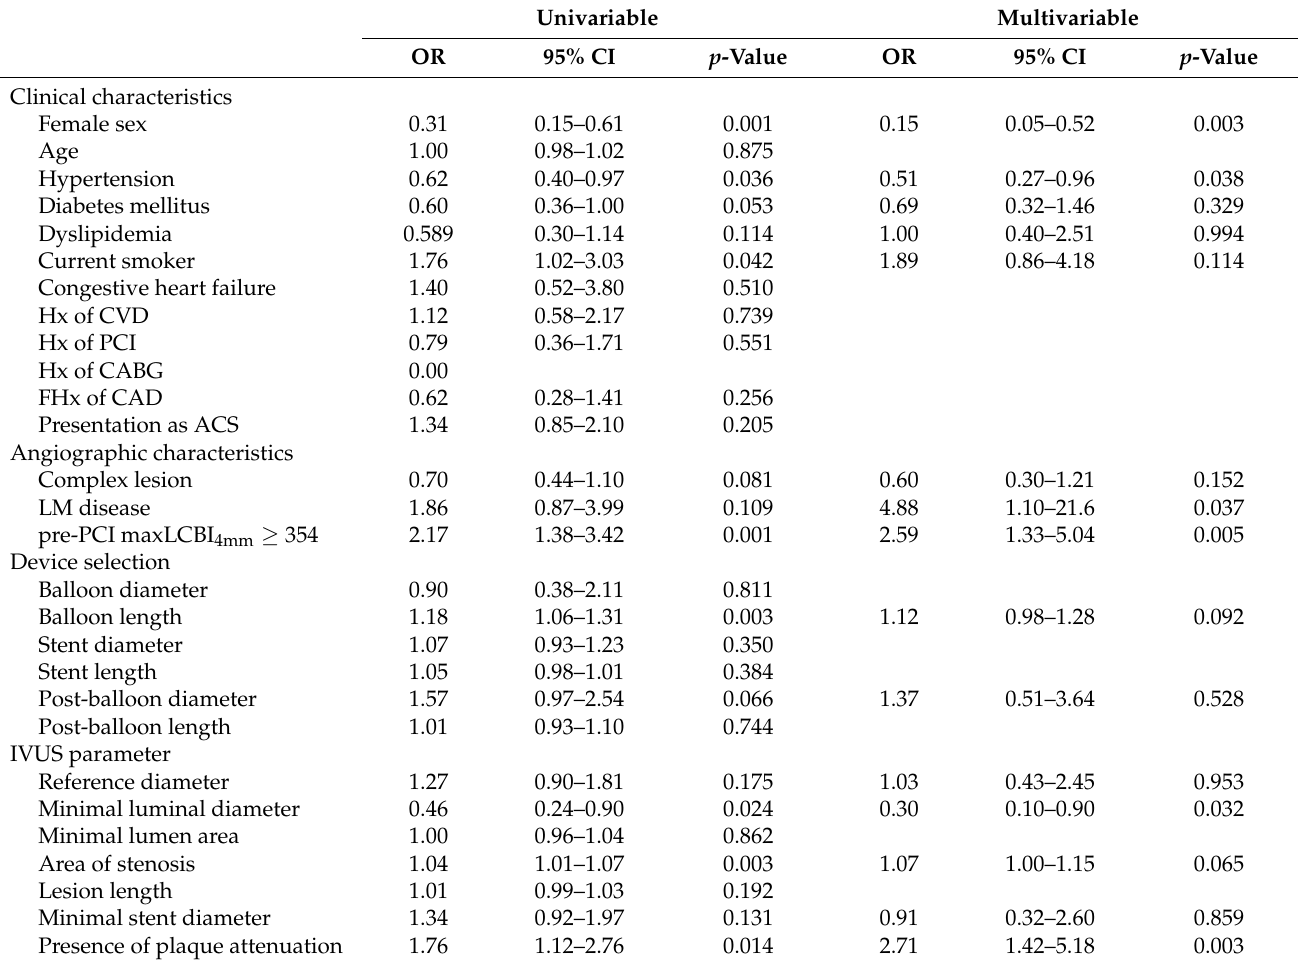
Table 4. Association between TIMI flow and clinical